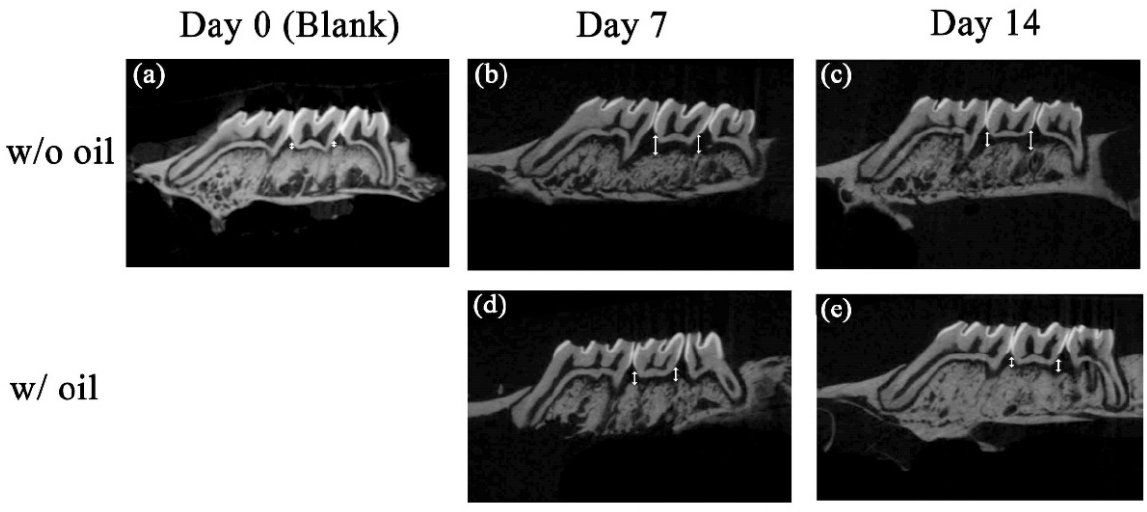
Figure 1. Micro CT images showing bone loss measurements for each group at Day0 ( a ), Day 7 ( b , d ) and Day 14 ( c , e ). On the sagittal side, radiographic bone loss was detected from CEJ to ABC (white arrow). The bone loss for SM oil samples ( b , c ) were lower than the oil-free groups ( d , e ). Figure 2 shows total bone loss (TBL) and furcation bone loss (FBL). These figures show that the change in furcation bone loss level showed no significant difference during the entire experimental period ( p = 0.891 and 0.284 for Day 7 and Day 14, respectively) (Figure 2a). Nevertheless, a significant difference for TBL was seen in CEJ-ABC distances between sample teeth ligated with and without SM oil on Day 14 ( p < 0.05) (Figure 2b).